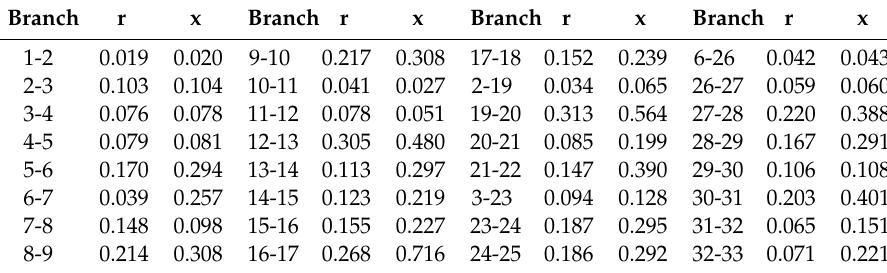
Table 1. Modified 33-bus system branch parameter (p.u.).